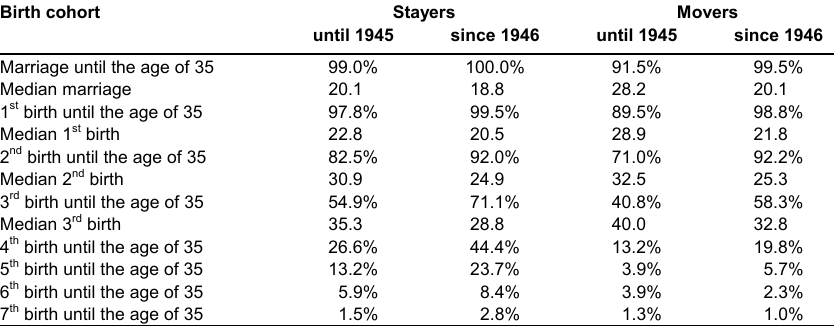
Table 5: Family formation process of female Turkish ‘movers’ and ‘stayers’ Stayers MoversBirth cohort until 1945 since 1946 until 1945 since